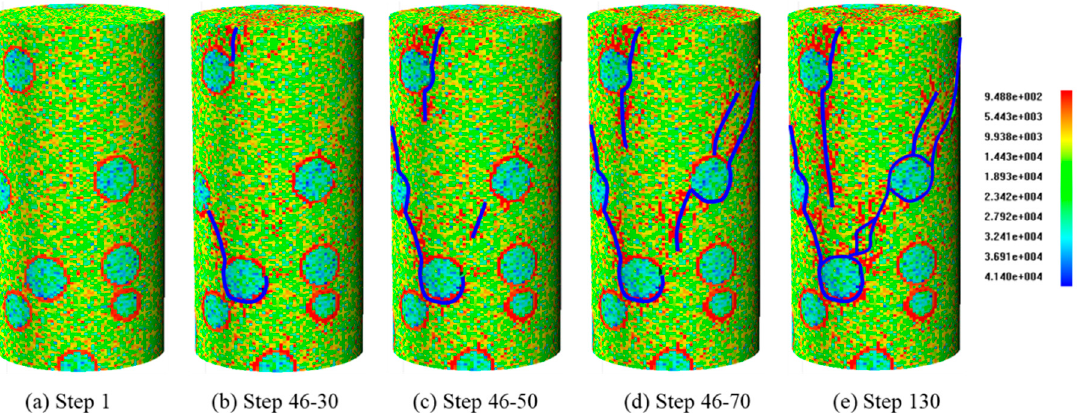
Figure 19. Schematic diagram of the fracture propagation process during glutenite rupture.